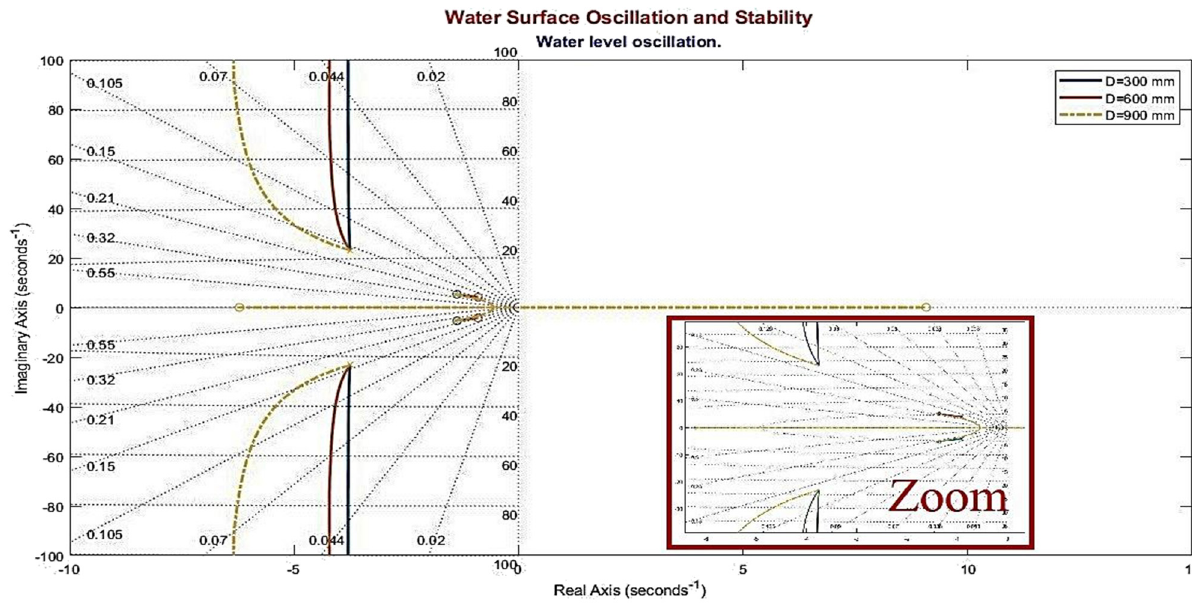
Figure 6: Stability of the system with di ff erent diameter e ff ects.